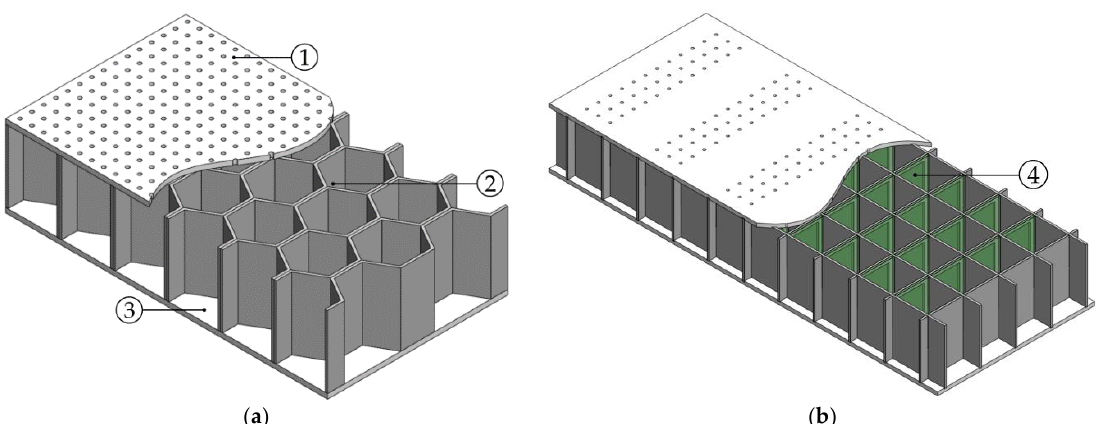
Figure 1. ( a ) Conventional acoustic liner with hexagonal honeycomb structure consisting of perforated face sheet, 1, hexagonal honeycomb core, 2, and, a back plate, 3; ( b ) novel liner concept with partially flexible walls, 4.